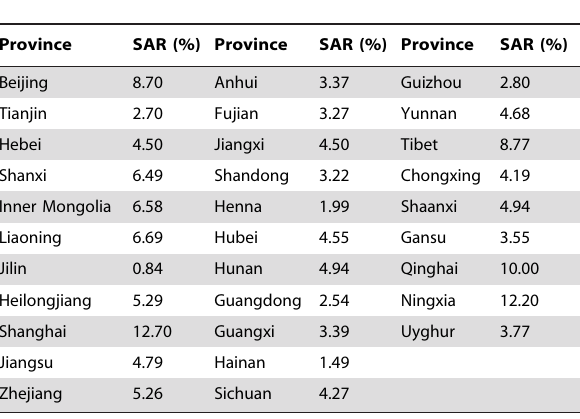
Table 2. Spontaneous abortion rates (SAR) by province from 1988 to1997 in China